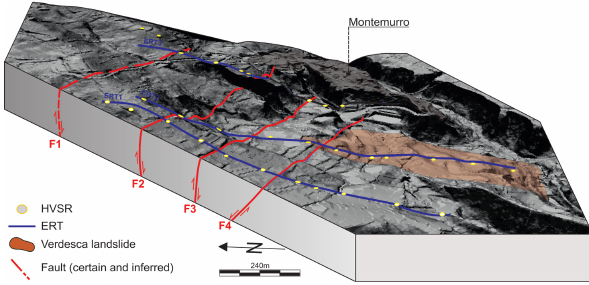
Figure 7. 3-D surface digital elevation model of the Montemurro area showing the faults and the location of ERT profiles and